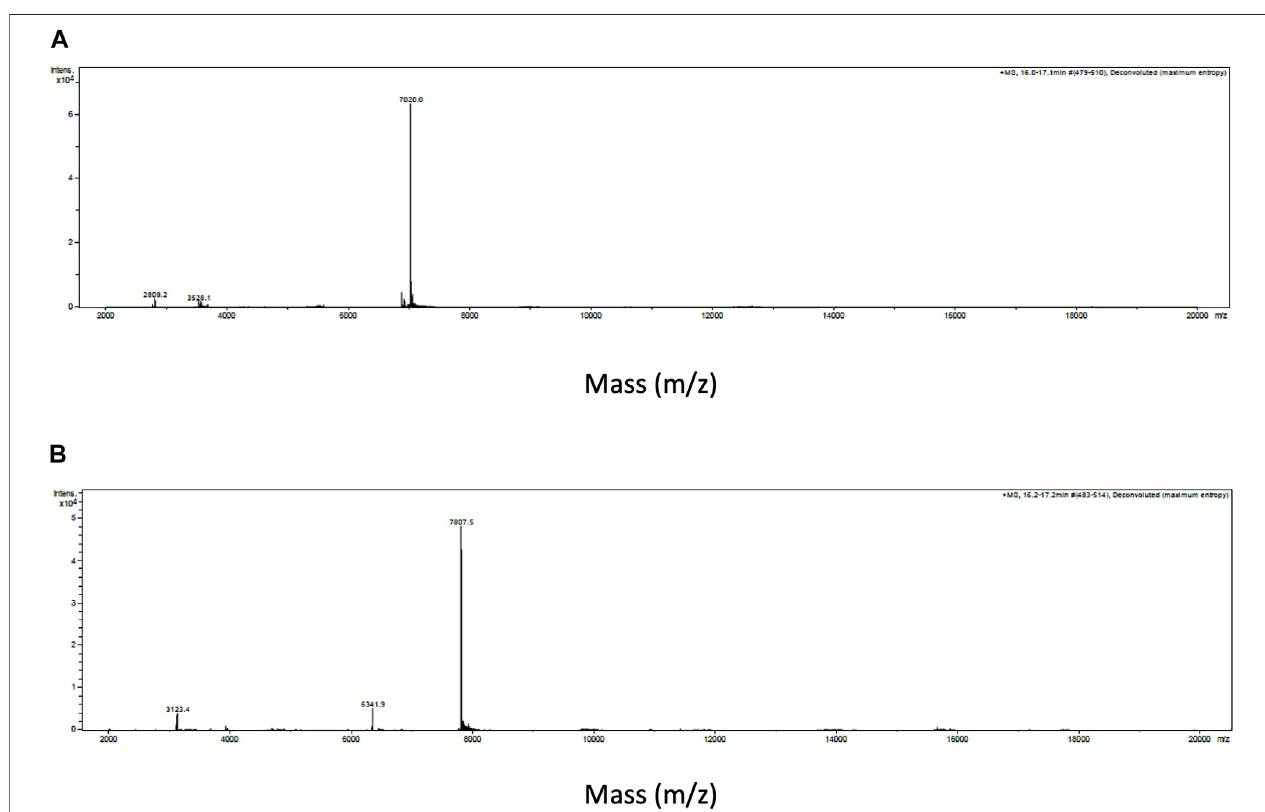
FIGURE 3 | Intact protein MALDI-TOF chromatogram of (A) α -Elapitoxin-Nn2a indicating an intact mass of 7,020.0 Da and (B) α -Elapitoxin-Nn3a indicating an intact mass of 7,807.5 Da.